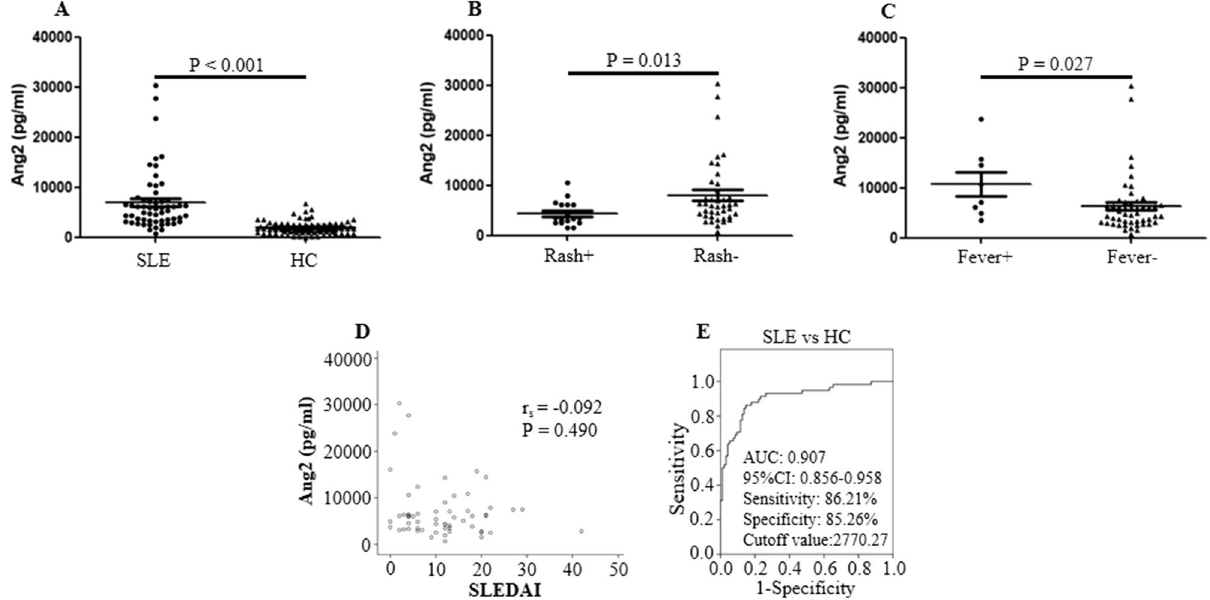
Figure 1. Comparison of Ang2 concentrations between SLE patients and healthy controls in the training cohort. ( A ) Serum Ang2 levels in 58 SLE patients and 95 healthy individuals were detected by enzyme-linked immunosorbent assay. Each symbol represents an independent SLE patient and healthy control. ( B – C ) Ang2 expression in SLE patients distributed in accordance with rash and fever. ( D ) Correlation between SLEDAI and Ang2 levels. ( E ) Receiver-operating characteristic (ROC) curve analysis of serum Ang2 for the diagnosis of SLE. The ROC for Ang2 supplied area under the ROC curve (AUC) with its associated 95% confidence intervals, sensitivity, specificity and cutoff value. Mann–Whitney U test and associated P values are indicated. The correlation was evaluated with Spearman’s nonparametric test. SLE, systemic lupus erythematosus; HC, healthy control; SLEDAI, systemic lupus erythematosus disease activity index; AUC, area under the ROC curve. The ROC curves plot (1-Specificity) % on the x-axis versus the sensitivity (%) on the